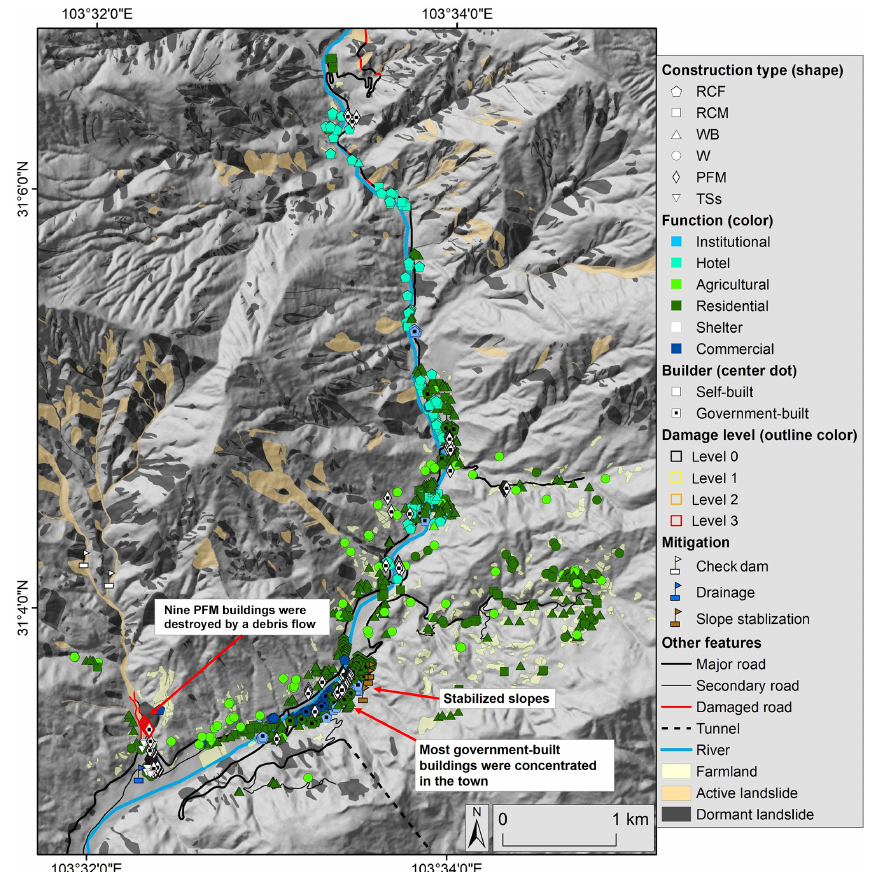
Figure 6. The inventory of the situation in 2010 before the monsoon, showing the buildings, roads and remedial measures for the period between 2008 and 2010. Overlaid are the active landslides in 2009. A debris flow destroyed nine PFM shelters, after which two check dams and a drainage system were